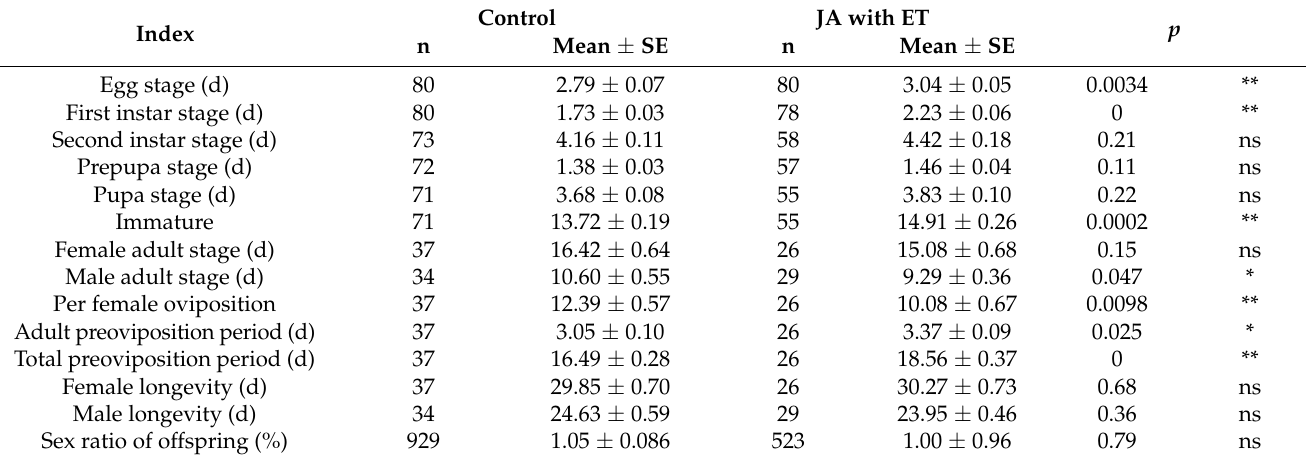
Table 2. Effect of the JA with ET treatment of faba bean plants on the development and reproduction of offspring of Frankliniella occidentalis